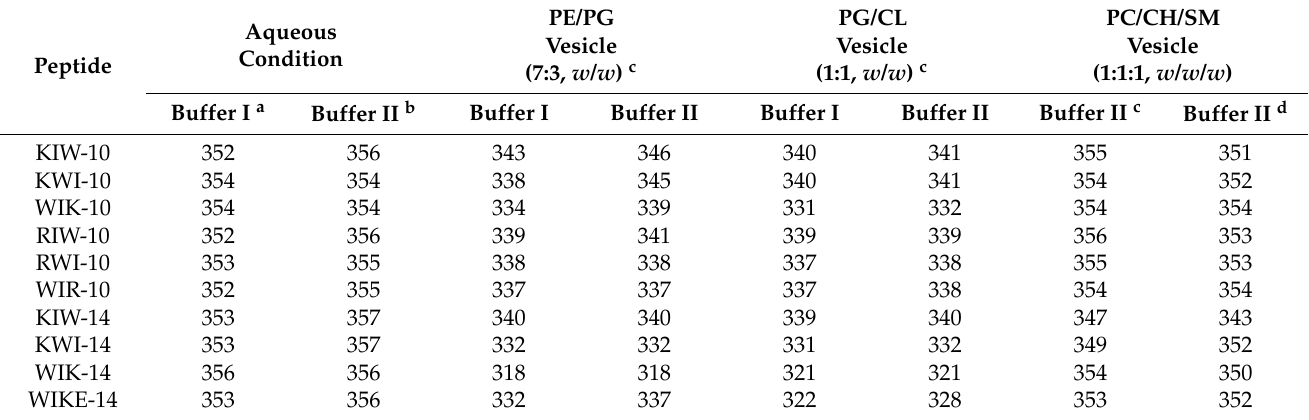
Table 2. Maximum tryptophan emission wavelength of the designed peptides with aqueous buffers and membrane environments (lipid